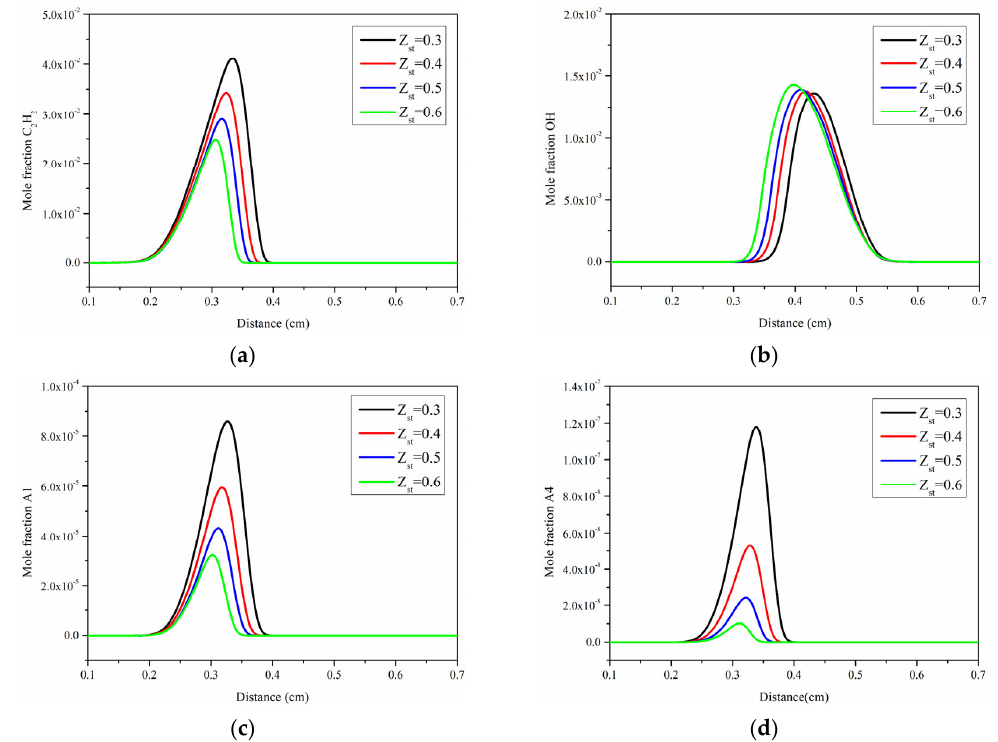
Figure 8. The mole fraction distributions of C 2 H 2 ( a ), OH ( b ), A1 ( c ), and A4 ( d ) in cases 2.1–2.4.